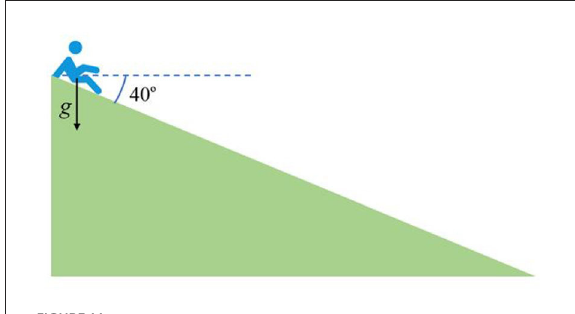
FIGURE11 Equivalent schematic diagram of the escape slides at each Exit when the airliner is level. reduce the evacuation efficiency of the people in the cabin.